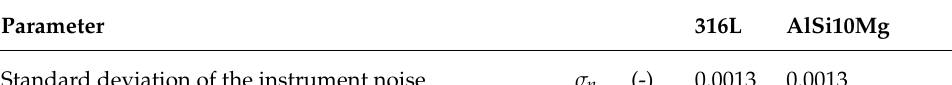
Table 5. Estimation of the uncertainty of the determined relative density due to the instrument noise U I . Parameter 316L AlSi10Mg Standard deviation of the instrument noise σ n (-) 0.0013 0.0013 Sensitivity b (%) 220.20 69.34 Uncertainty of the determined relative density via ECT U I (%) 0.02%